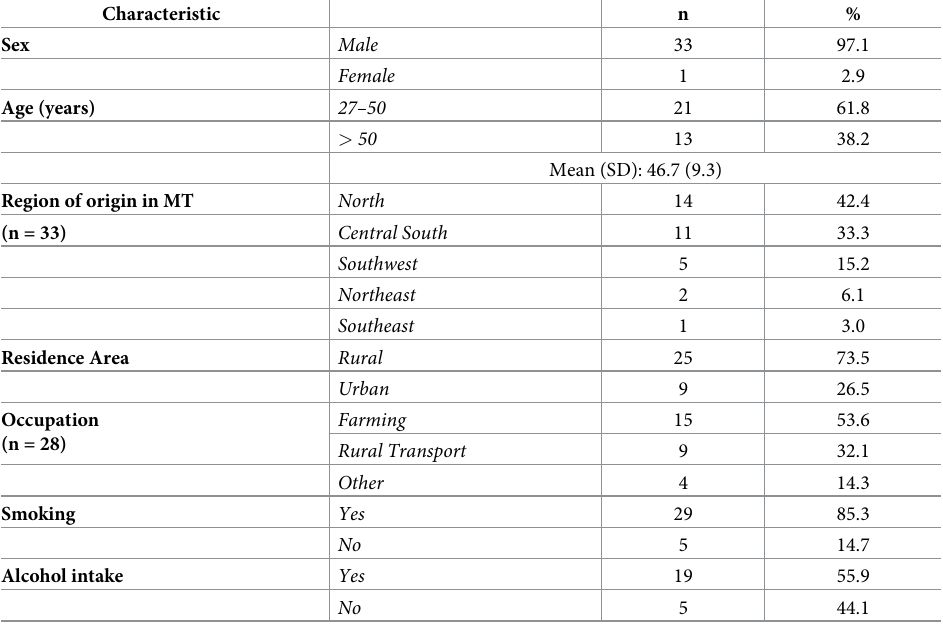
Table 1. Demographic and behavioral characteristics of patients with paracoccidioidomycosis caused by P . lutzii .